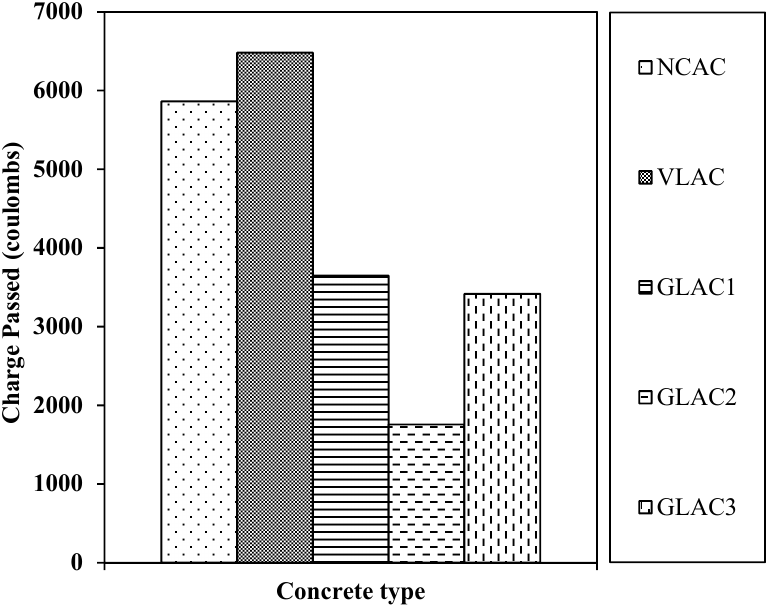
Figure 16. The 28-day chloride permeability of GLAC, NCAC and VLAC at W/C of 0.50.